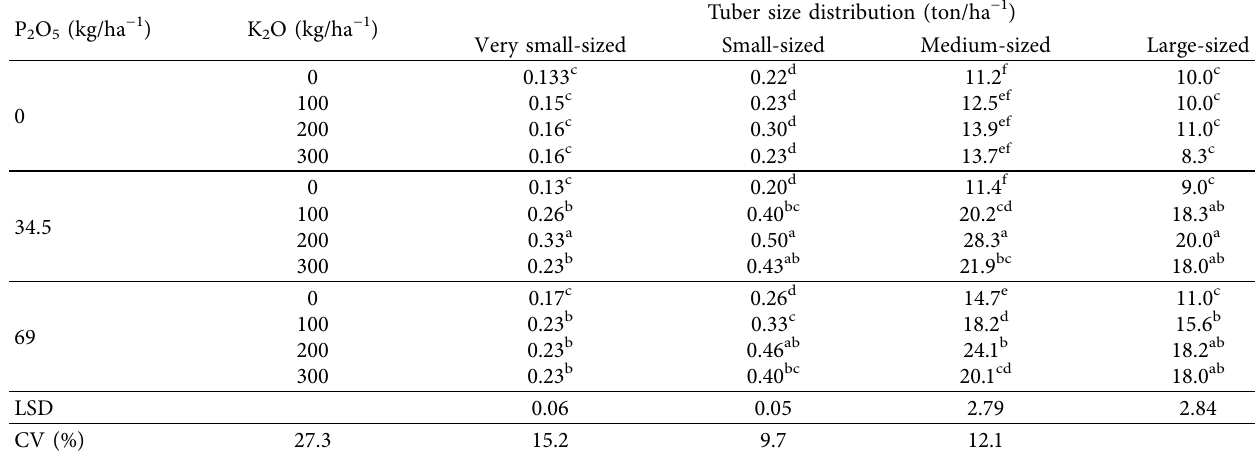
Table 4: Interaction effects of phosphorus and potassium fertilizers on the tuber size distribution of